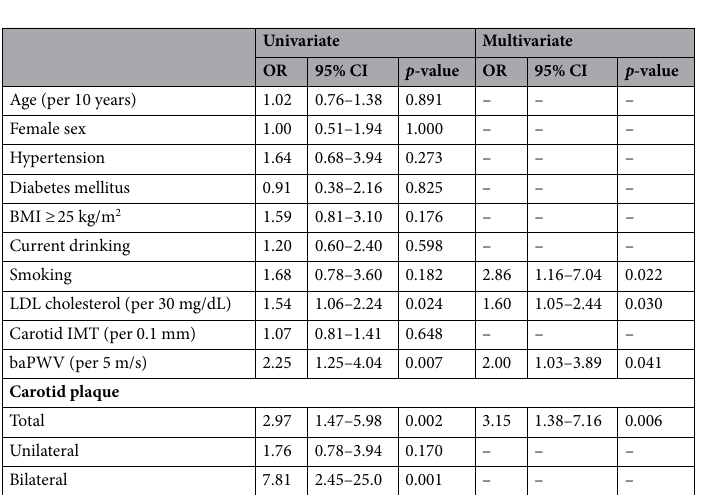
Table 2. Logistic regression analysis for predictors of RVO. baPWV brachial-ankle pulse wave velocity, BMI body mass index, CI confidence interval, IMT intima-media thickness, LDL low-density lipoprotein, OR odds ratio, RVO retinal vein